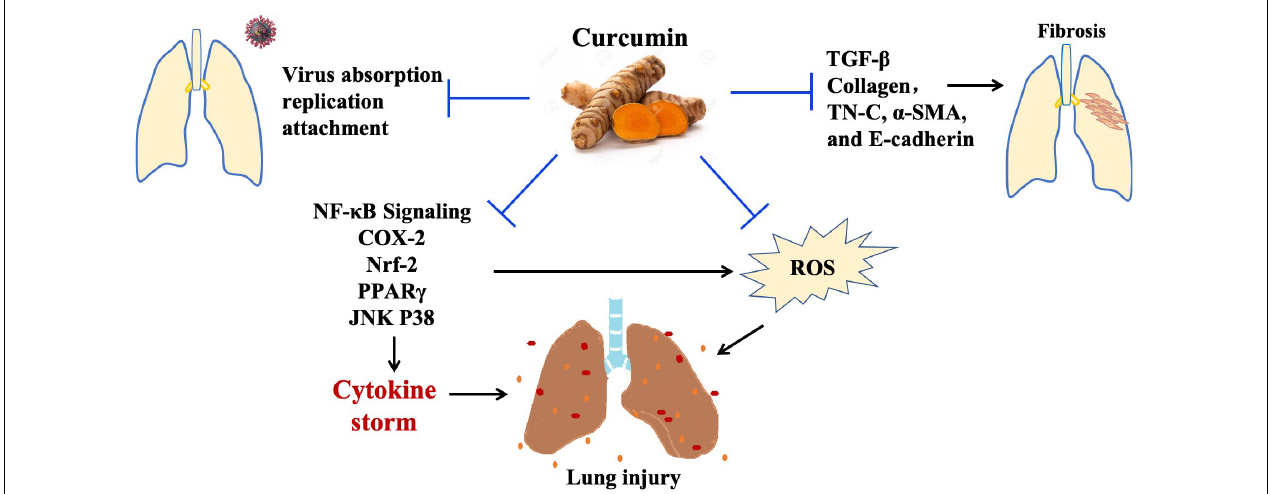
FIGURE 3 | The effects of curcumin in virus associated with severe pneumonia. Curcumin inhibits virus-induced lung injury through its antivirus, anti-inflammation, antioxidant activity. In addition, curcumin could suppress fibrosis by targeting TGF- β signaling. Abbreviations: Nrf2, nuclear factor erythroid-derived 2; NF- κ B, nuclear factor- κ B; PPAR γ , peroxisome proliferator-activated receptor γ ; TNF- α , tumor necrosis factor-alpha; COX2, cyclooxygenase-2; I κ B, inhibitor of kappa B; IL, interleukin; JNK, c-Jun N-terminal Kinase; TN-C, tenascin-C; α -SMA, alpha-smooth muscle actin.